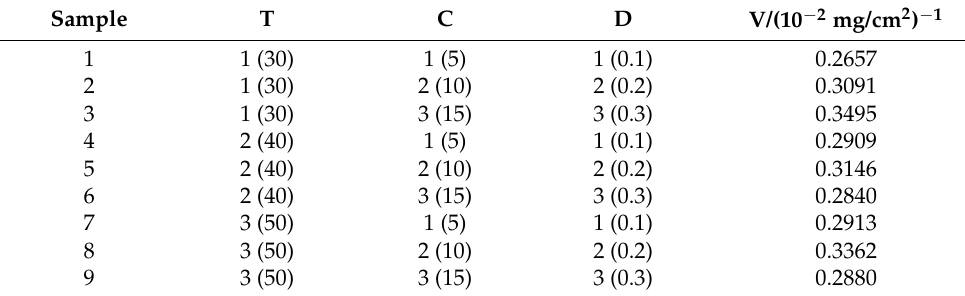
Table 4. Results of the